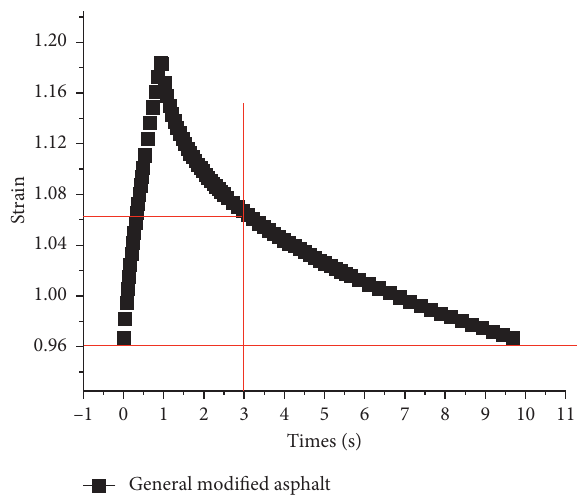
Figure 5: Creep-recovery response of general modified asphalt.